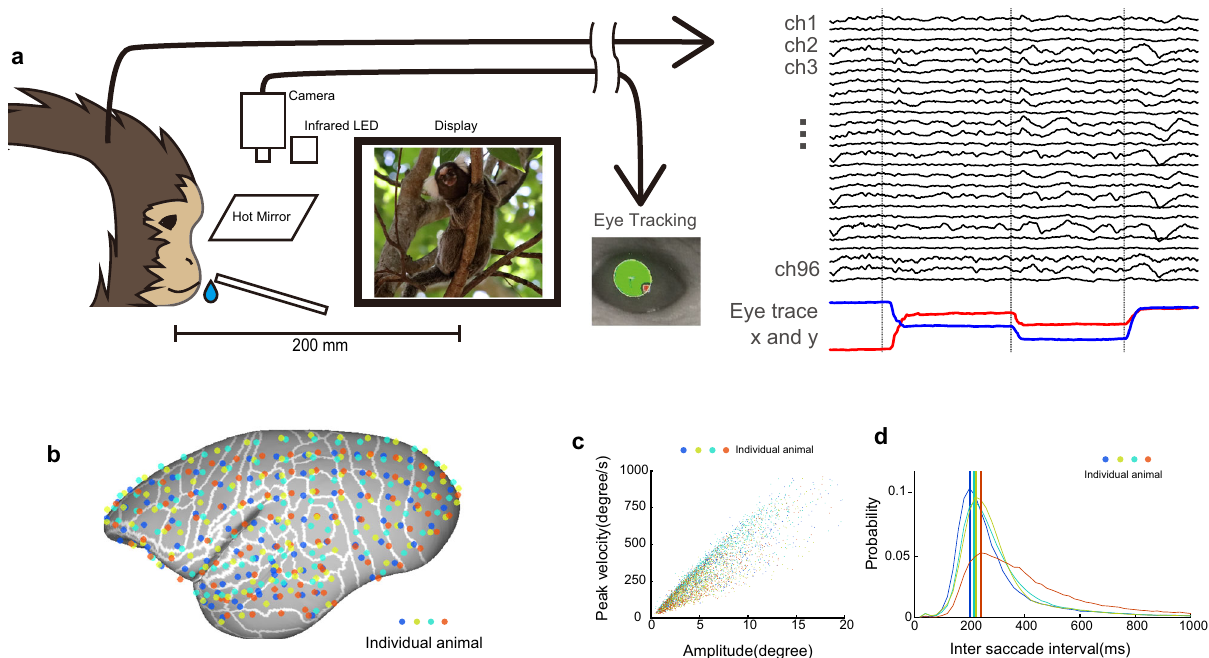
Fig. 1 Large-scale ECoG recording of natural visual behavior. a A schematic illustration of the experimental design. The marmoset viewed naturalistic movies while its eye movements and ECoG signals were recorded. A liquid reward was delivered at a random interval irrespective of behavior to keep the subject awake for a longer duration. b The electrode positions of the four subject animals. The ECoG array with 96 channels covered almost the entire lateral hemisphere of the marmoset brain. The electrode positions were determined by in vivo CT scans and the cortical areas inferred from registration of subject MR images to the marmoset atlas. c The main sequence of saccades during the free-viewing paradigm. d Inter-saccade interval. The marmoset made rapid eye movements every 220ms during natural visual behavior. Color represents individual marmosets as in ( b